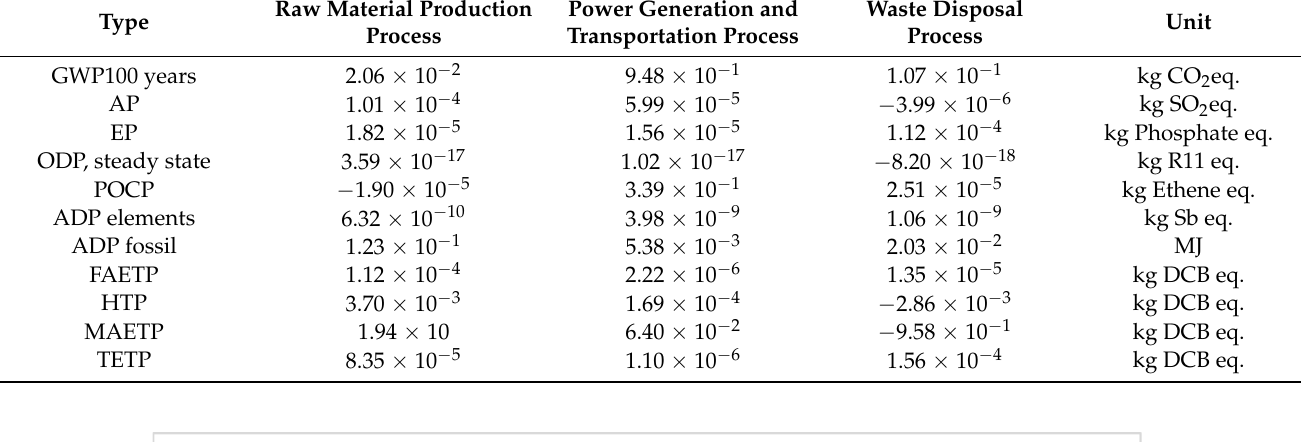
Table 4. LCA eigenvalue analysis results of coal-fired power plants based on the CML2001—Jan. 2016 method.